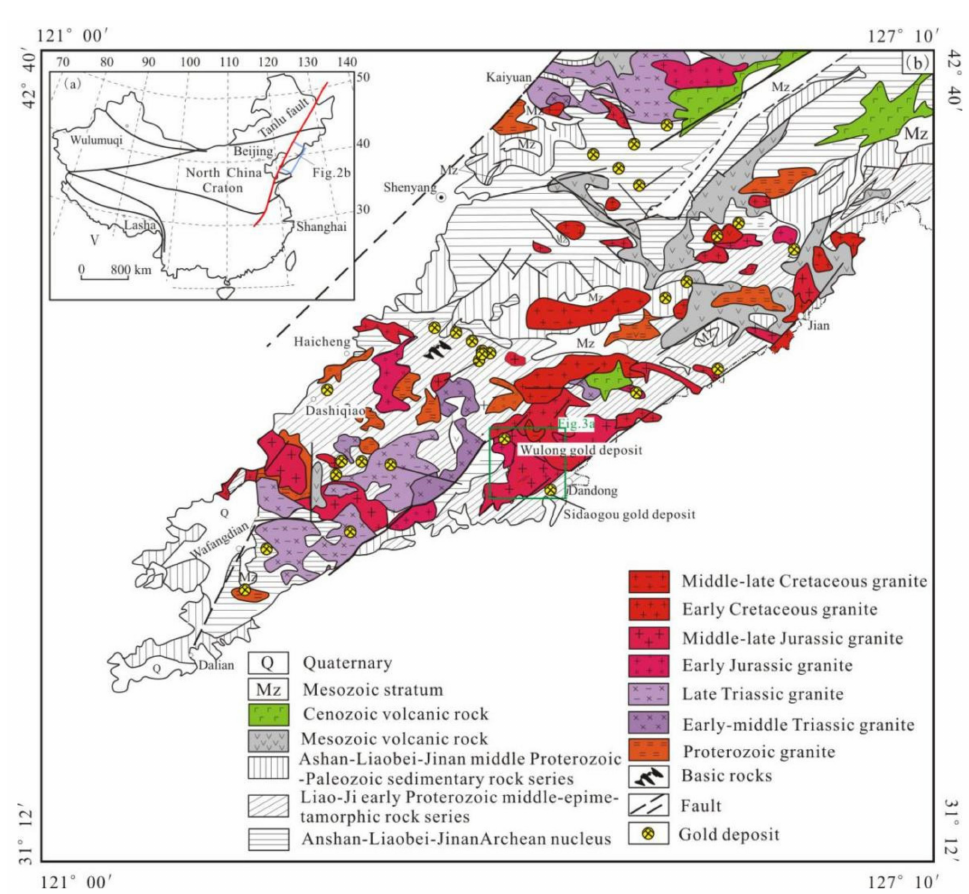
Figure 2. ( a ) Location map of the Liaodong Peninsula. ( b ) Sketch map showing the regional geology and distribution of gold deposits in the Liaodong Peninsula (modified from